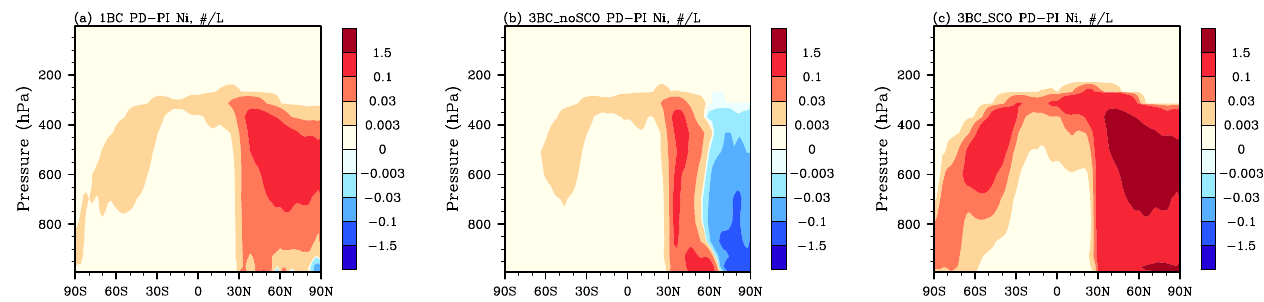
Fig. 5. PD–PI annual average changes of grid-mean ice number concentration in mixed-phase clouds from 1BC (a) , 3BC noSCO (b) and 3BC SCO (c) simulations (#L − 1 ).